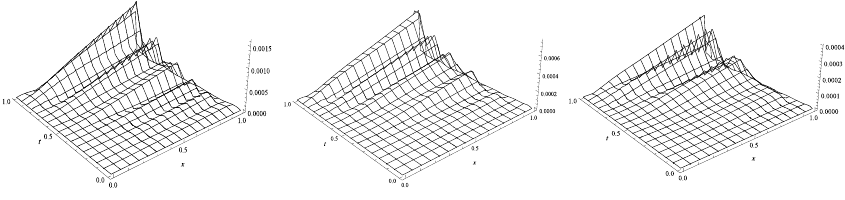
Figure 1. Max absolute error with ε = 10 − 8 (Left: N = 200; Middle: N = 400; Right: N = 800) for Example 1.